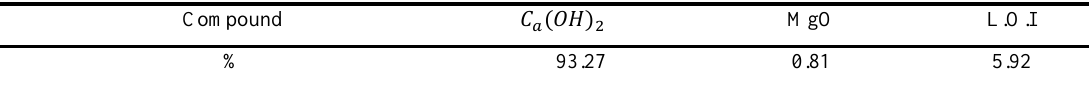
Table 2 Lime chemical composition